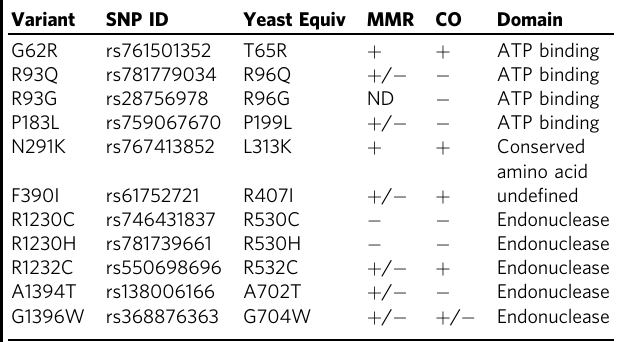
Table 2 Analysis summary of yeast equivalents to human MLH3 SNPs for defects in crossing over and mismatch